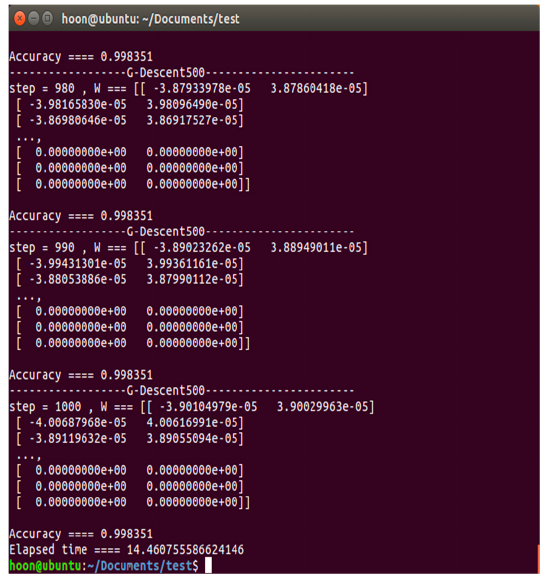
Figure 16. Scenario 2 experiment result: single learning (Adam ⇒ G-Descent).